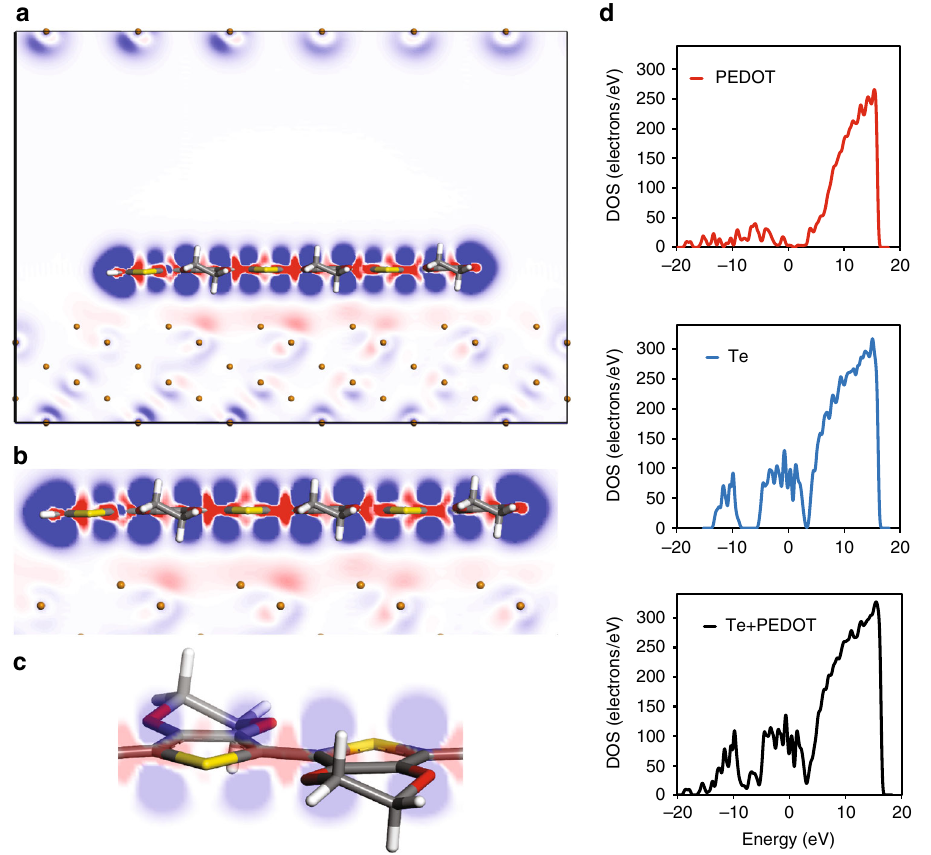
Fig. 2 DFT calculations reveal electronic effects at the organic-inorganic interface. a Charge density redistribution within polaronic PEDOT hexamer (EDOT 6 ) + 2 on the Te surface, as calculated by the difference in total charge density with NW surface charge density and hexamer charge density as subsets ( b ) Electron transfer from Te surface to PEDOT chains monitored by increase of charge density (red) at the interface and decrease of charge density (blue) at the Te phase ( c ) Detailed visual illustrating an increase of charge density (red) within PEDOT monomer bonds and σ -orbitals of PEDOT carbon atoms and a concomitant decrease (blue) observed for the π -orbitals of PEDOT carbon atoms on Te NW surface ( d ) Density of States (DOS) calculated individually for PEDOT and Te compared with Te-PEDOT hybrid. The DOS of the hybrid is not renormalized due to minimal charge transfer across the interface